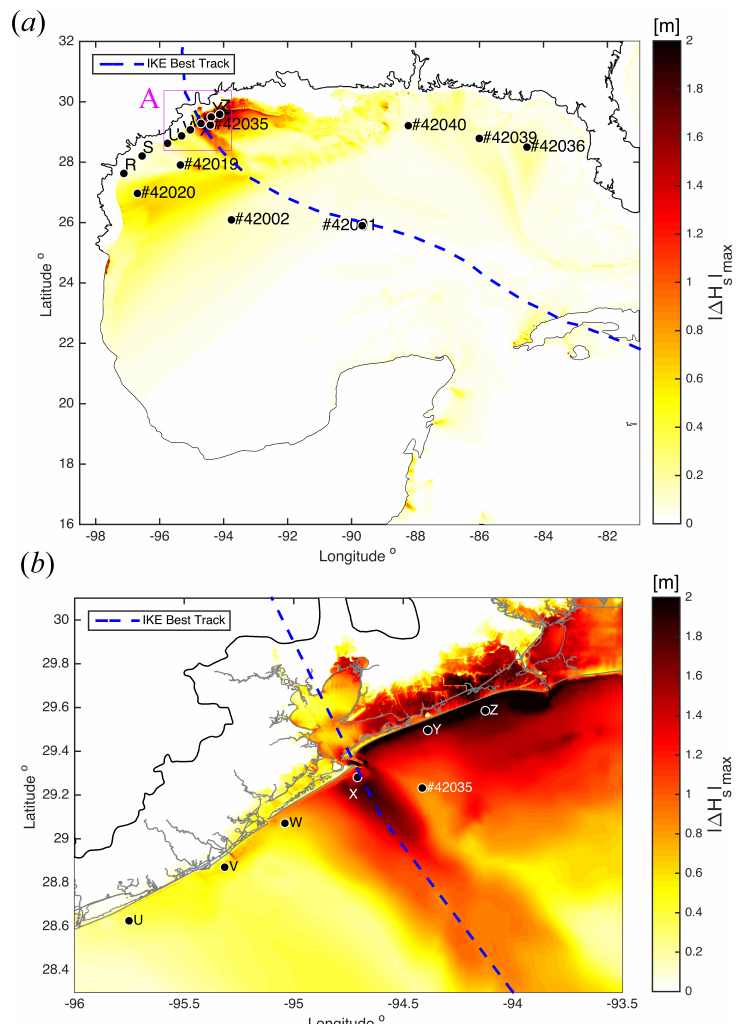
Figure 4. Wave model sensitivity to dynamic exchange between wave and surge models in term of the spatial distribution of the absolute difference between significant wave height H s , extracted from the Fully coupled wave-surge and Stand Alone WAVEWATCH III (WW3) models; Gulf of Mexico ( a ) landfall region ( b ). All model configurations and results are pre-decisional and for official use